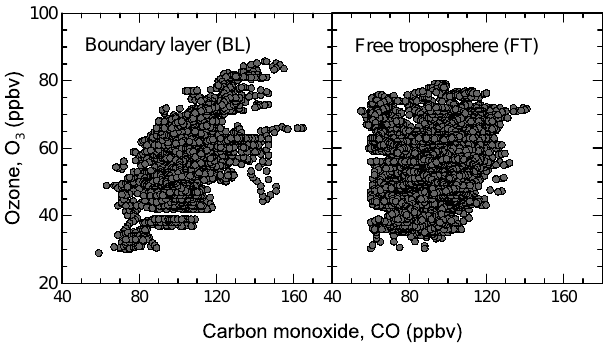
Figure 7. O 3 versus CO in the boundary layer (BL) and the free tro- posphere (FT) for all TRAQA and SAFMED vertical profiles (dust observations